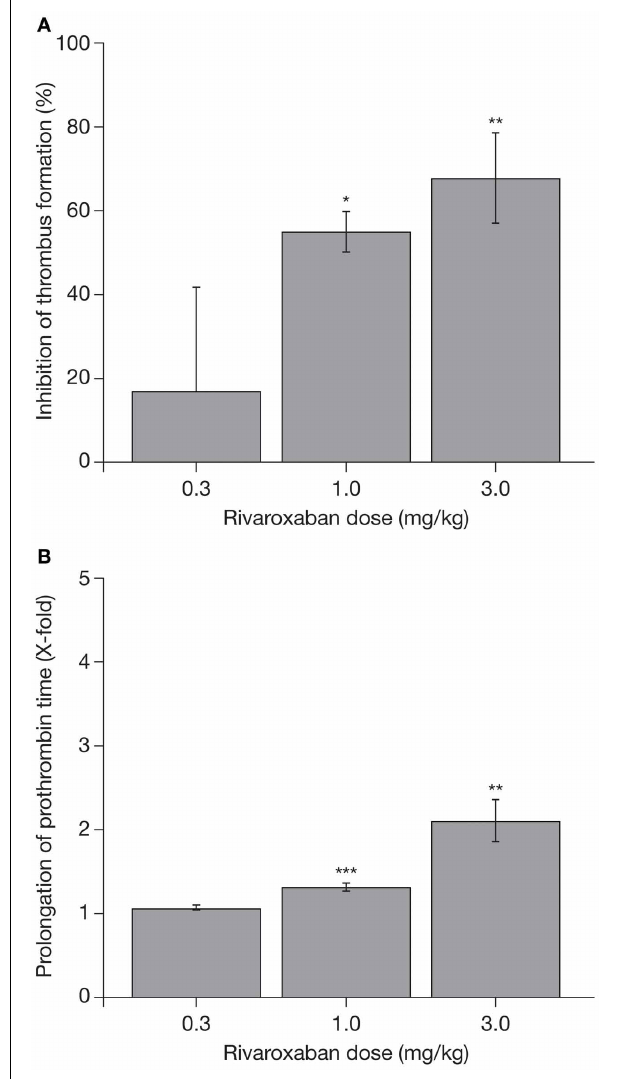
FIGURE 2 | (A) Reduction in thrombus formation and (B) prolongation of prothrombin time with rivaroxaban in a rabbit arteriovenous shunt model. Each value represents the mean ± SEM of six animals. ∗ p < 0 . 05; ∗∗ p < 0 . 01; ∗∗∗ p < 0 . 001. Data published previously in the Journal of Thrombosis and Haemostasis (Perzborn et al.,